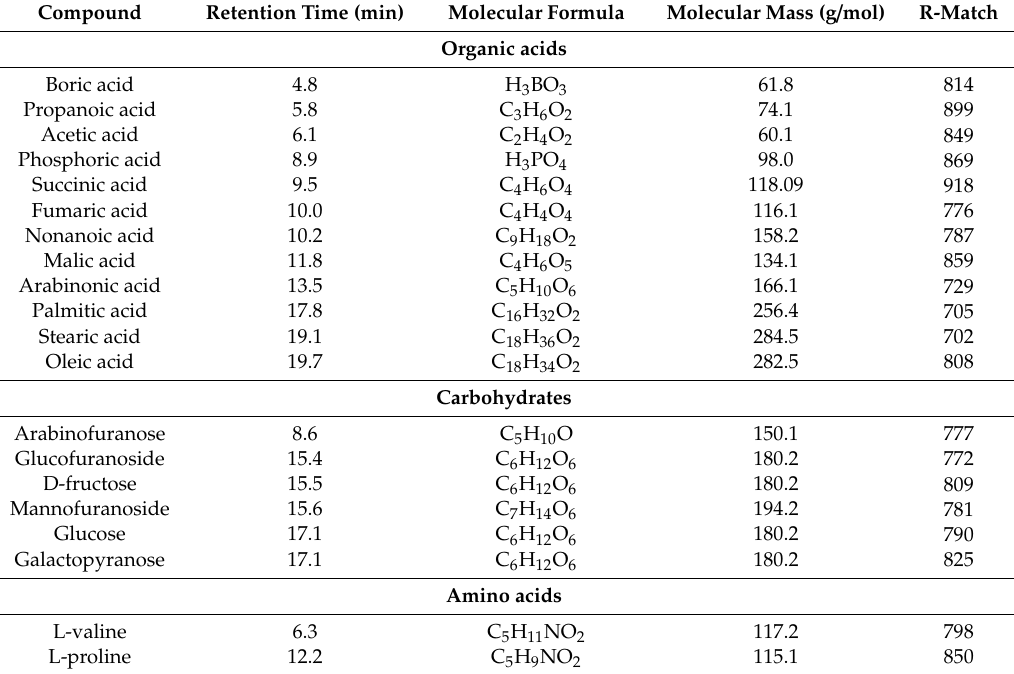
Table 2. Organic acids, carbohydrates, and L-amino acids identified in leek extract (LE) by Gas Chromatography–Mass Spectrometry (GC–MS).